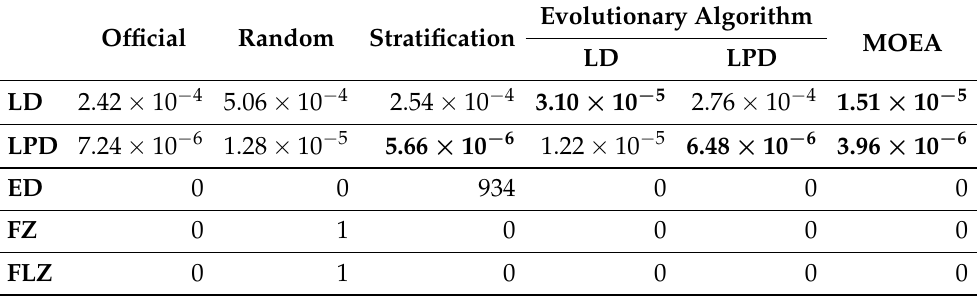
Table 10. Evaluation of the different splitting approaches of the Microsoft COCO data set. In bold the results that are better than the official method, usually employed in the literature. The results of the constrained alternative is not presented as the unconstrained approach obtains FZ and FLZ measures equal to